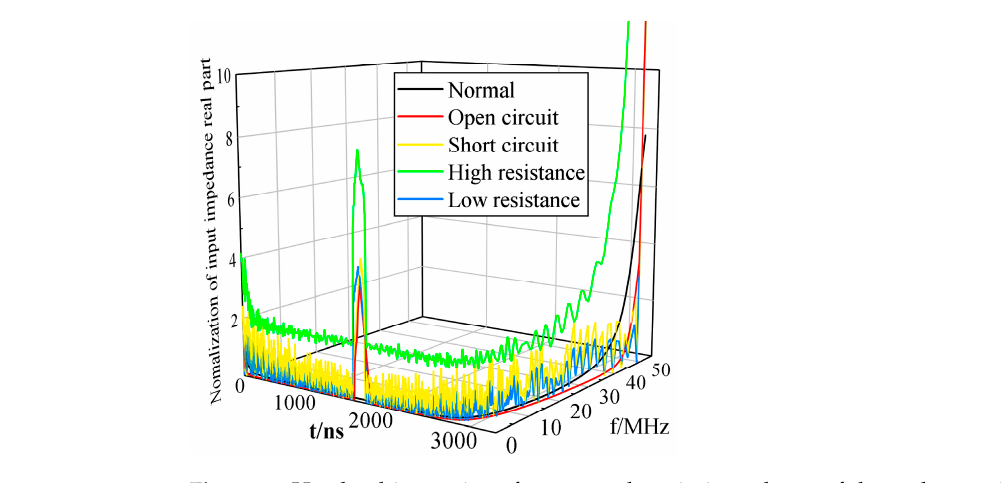
Table 2. Part of the sample database.